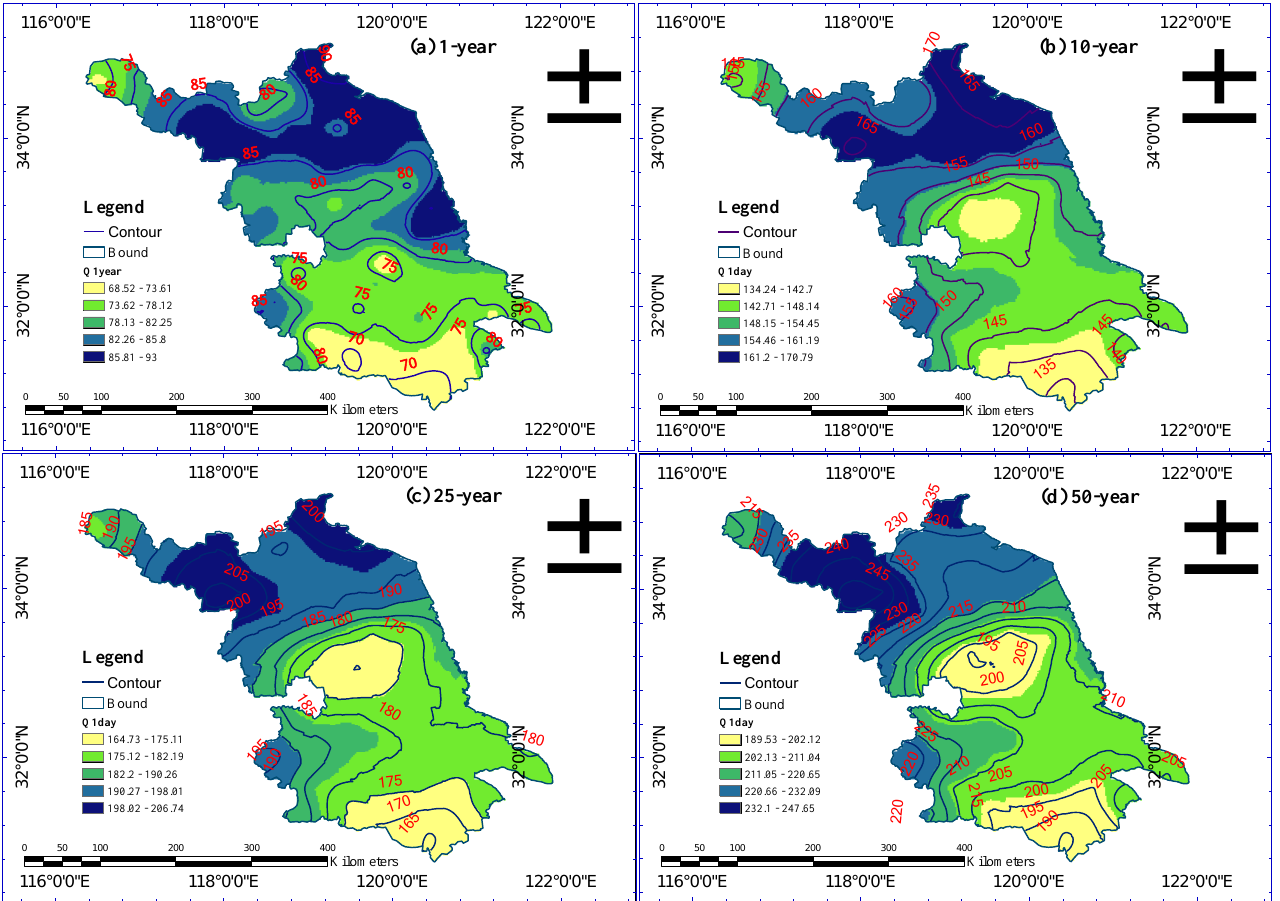
Figure 4. Map of quantile estimates for ( a ) 1-year, ( b ) 10-year, ( c ) 25-year, and ( d ) 50-year return periods. Three statistical criteria, RE , RMSE , and the correlation coefficient ( r ) are used to judge the precision of frequency estimates. The results can be found in Table 5. The average RE , RMSE , and r of all stations in the study area are 5.56%, 0.107 mm, and 0.969, respectively. This indicates that the estimation is in good agreement with the observation. Figure 5 shows a scatterplot of measured and observed quantiles at the same frequency for each site